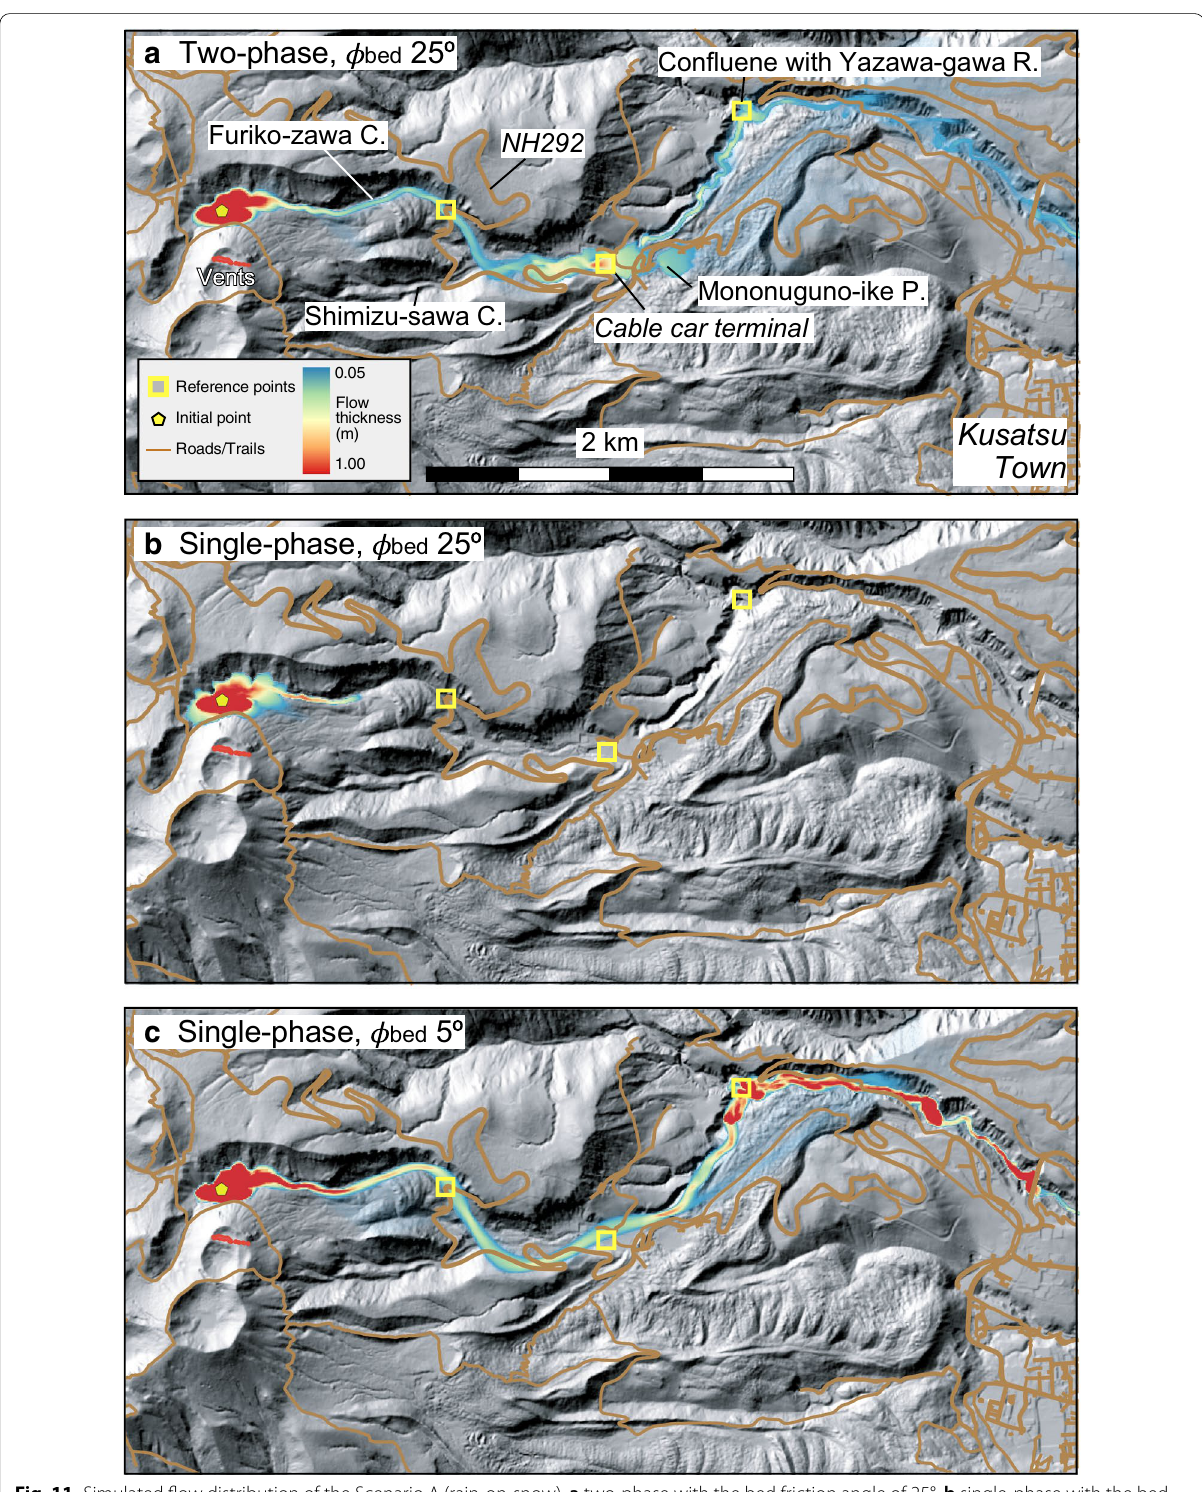
Fig. 11 Simulated flow distribution of the Scenario A (rain-on-snow), a two-phase with the bed friction angle of 25°, b single-phase with the bed friction angle of 25°, and c single-phase with the bed friction angle of